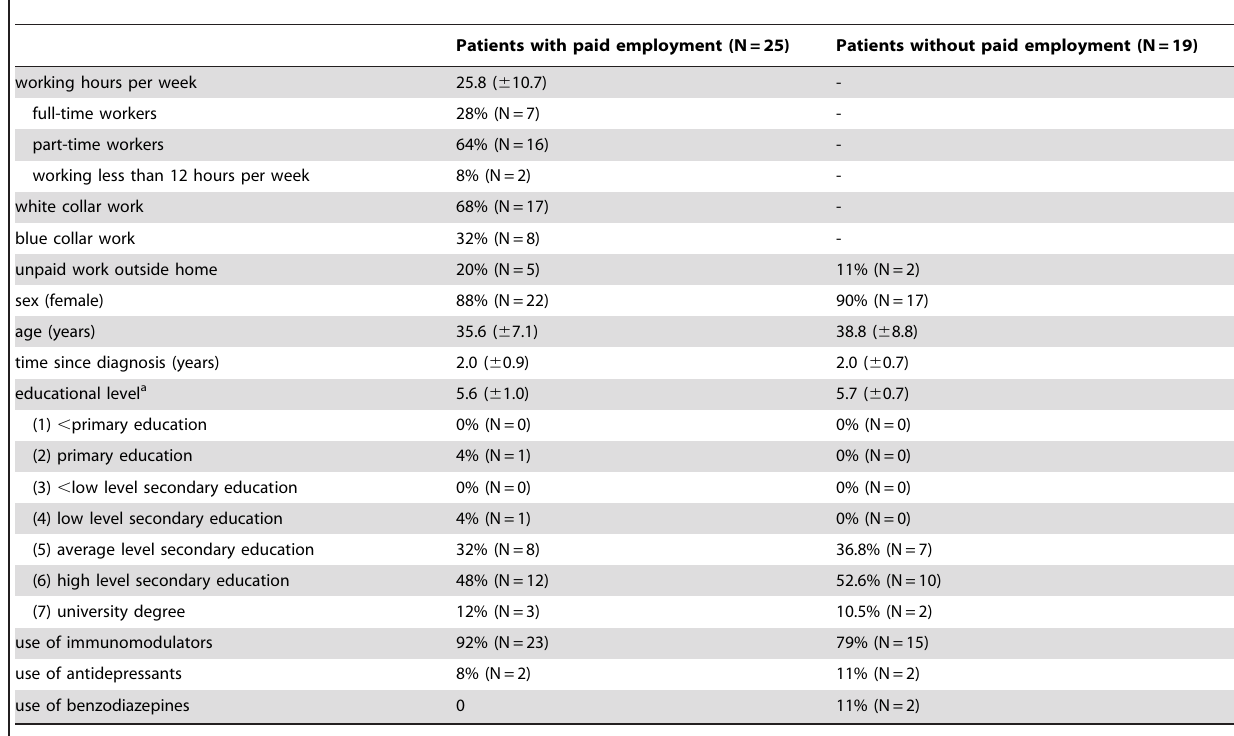
Table 1. Demographic and disease characteristics of the study